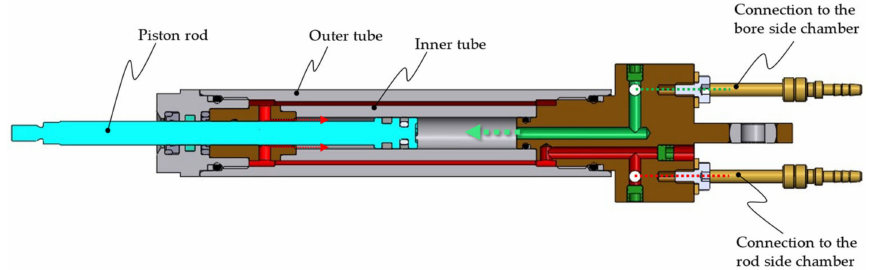
Figure 11. Sectioned view of the hydraulic cylinder from HAWE, illustrating the twin-tube design and the internal flow